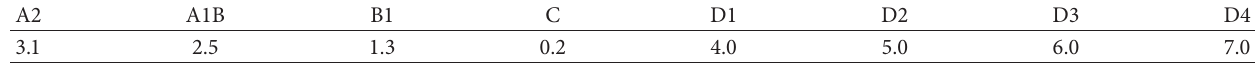
Table 2: Values of pMAI ( m 3 /ha/year ) of all the six forests for large instances.